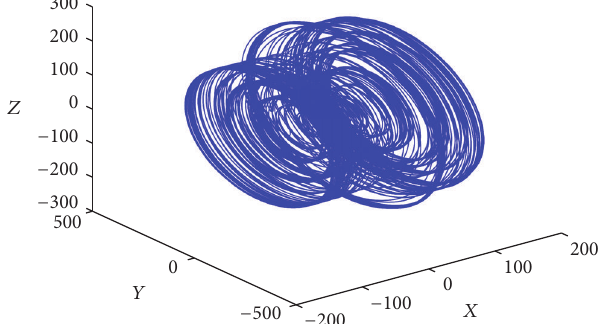
Figure 14: Projection over the subspace XYZ of the chaotic- transient solution.